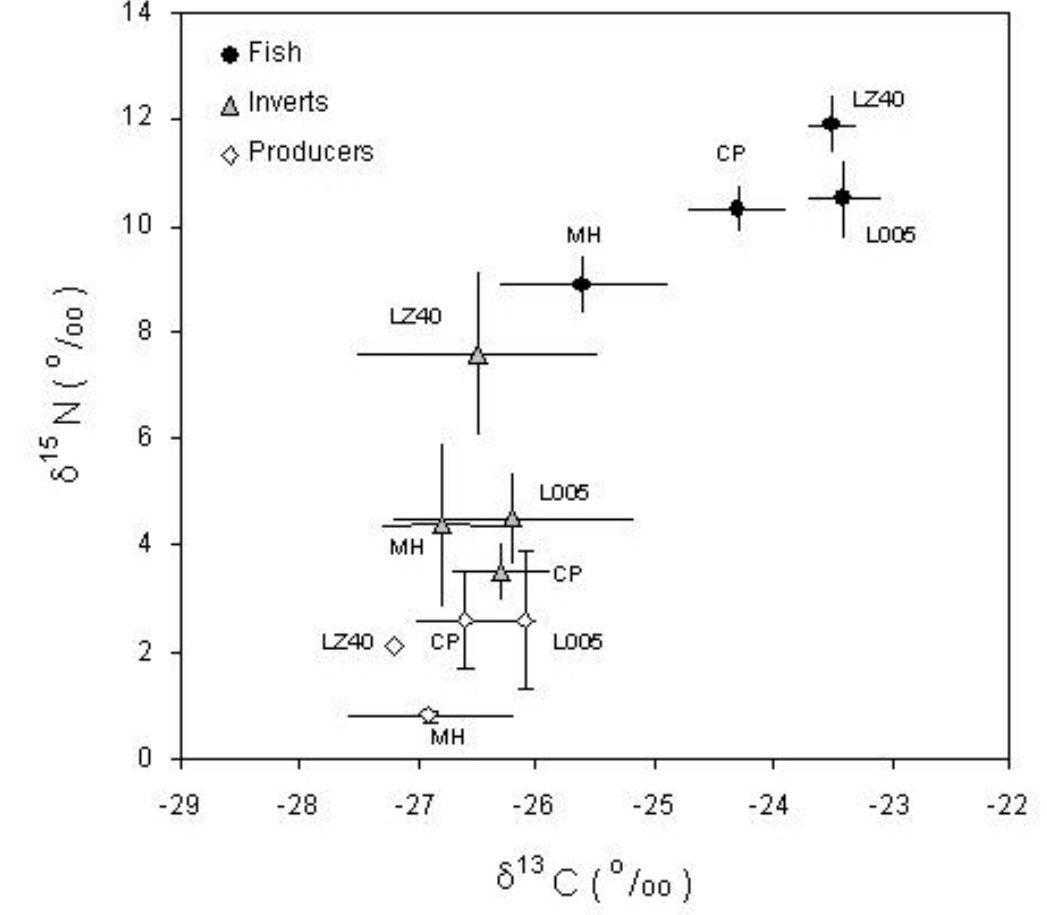
FIGURE 2. Overall δ 15 N and δ 13 C averages (+ one standard error) for fish, invertebrates, primary producers, and sediment / detritus, sampled at the four sites in Lake Okeechobee. Station names are given in Fig.